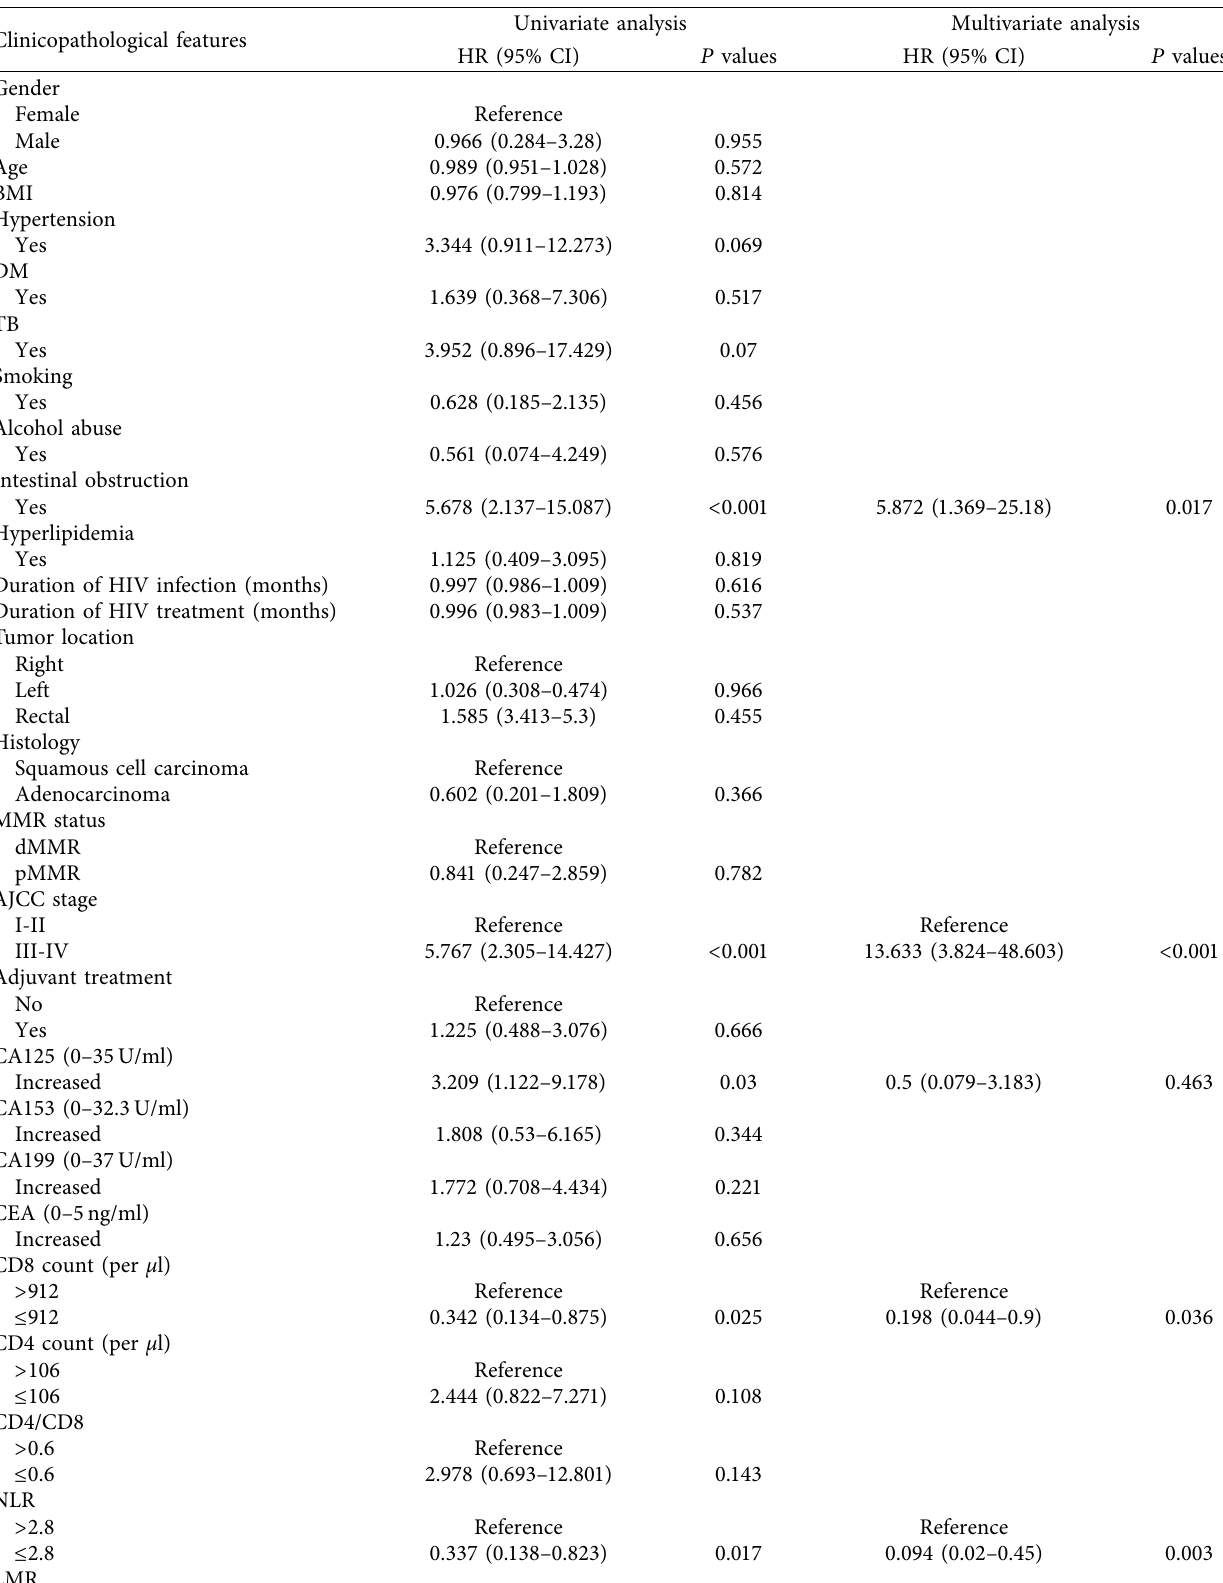
Table 2: Univariate and multivariate analyses of clinicopathologic variables and infammation biomarkers in relation to OS in patients living with HIV for